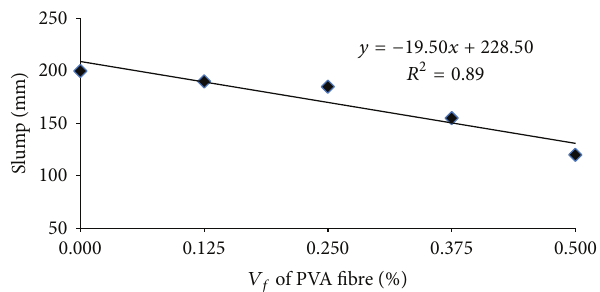
Figure 6: Relationship between PVA fiber volume fraction and slump.